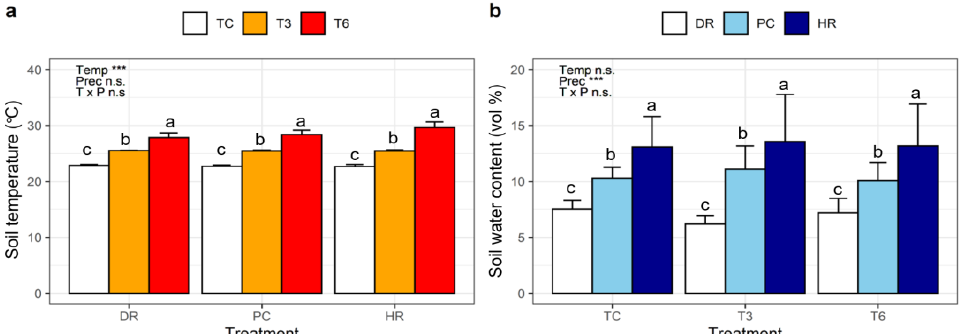
Figure 3. ( a ) Mean soil temperature (°C) and ( b ) mean soil water content (vol %) during the experimental period of extreme climate events. TC: ambient temperature, T3: +3 °C warming, T6: +6 °C extreme warming, DR: drought, PC: ambient precipitation, HR: heavy rainfall. Results of a two-way ANOVA are shown in each panel. Asterisks indicate significant differences between treatments; n.s.: not significant. Different letters indicate significant differences between treatment within each group factor. Error bars indicate the standard deviation of the mean ( n = 3). Table 1. Statistical significance ( p -values) of the two-way ANOVA of the effects of experimental extreme climate events on the measured variables.